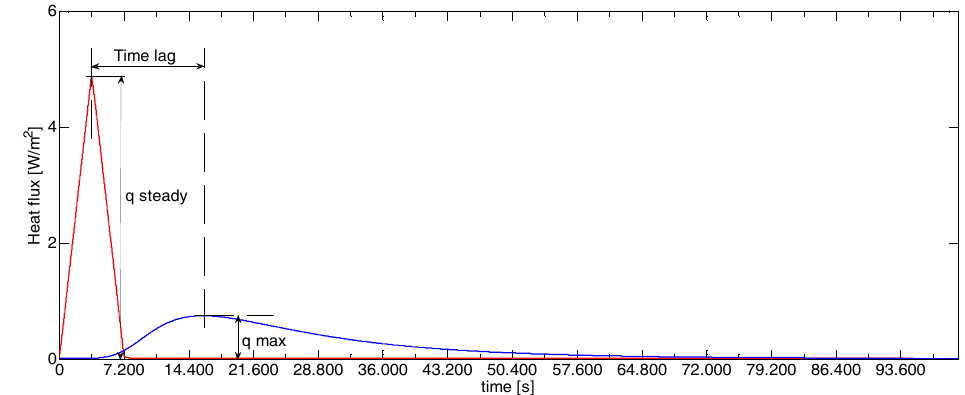
Figure 2. Equivalent steady state heat flux vs. actual heat flux for Expanded Perlite insulation in the light weight clay (LWC) block.